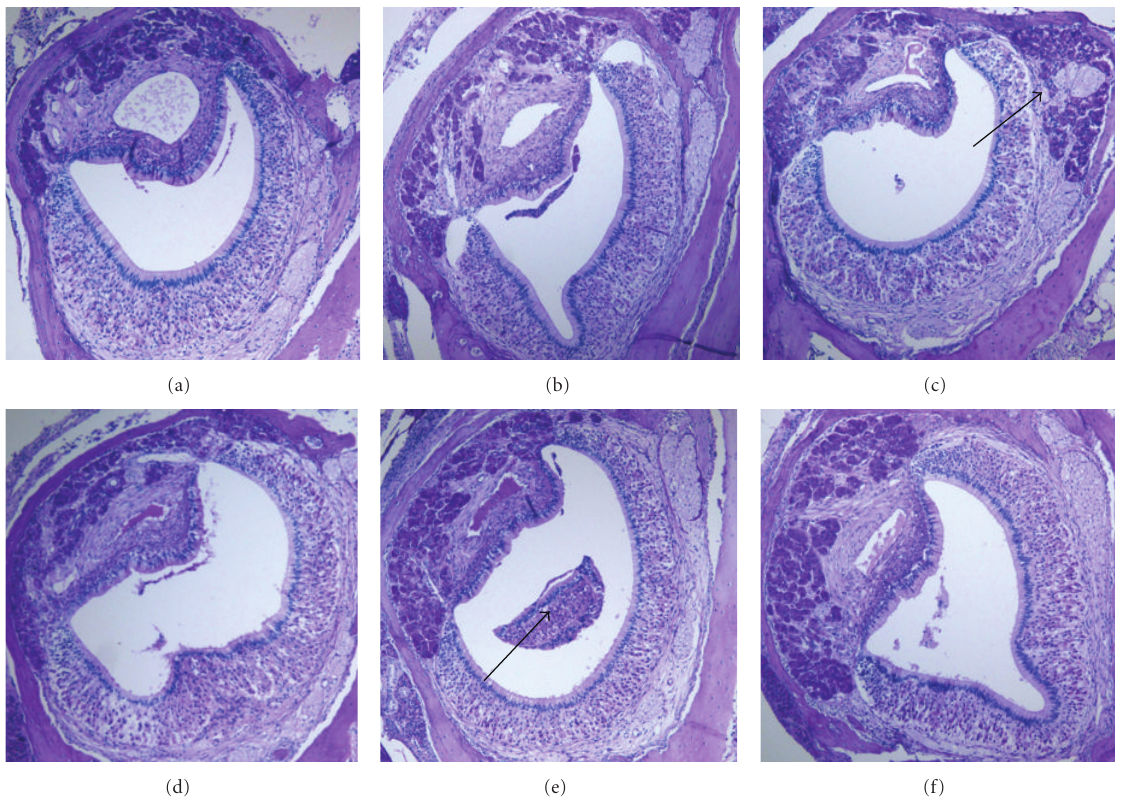
Figure 3: Histopathological images of nose-tissue sections stained with PAS on the 4th day. (a) Normal group; (b) saline group; (c) LPS group; (d) sTNFRI group; (e) antibiotic group; (f) sTNFRI/antibiotic group. A large PAS-stained area was observed in the LPS group ((c), arrow), and luminal inflammatory cell clumping was noted in the antibiotic group ((e), arrow) ( ×